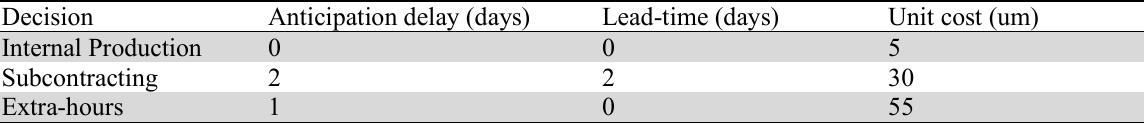
Production decisions characteristics